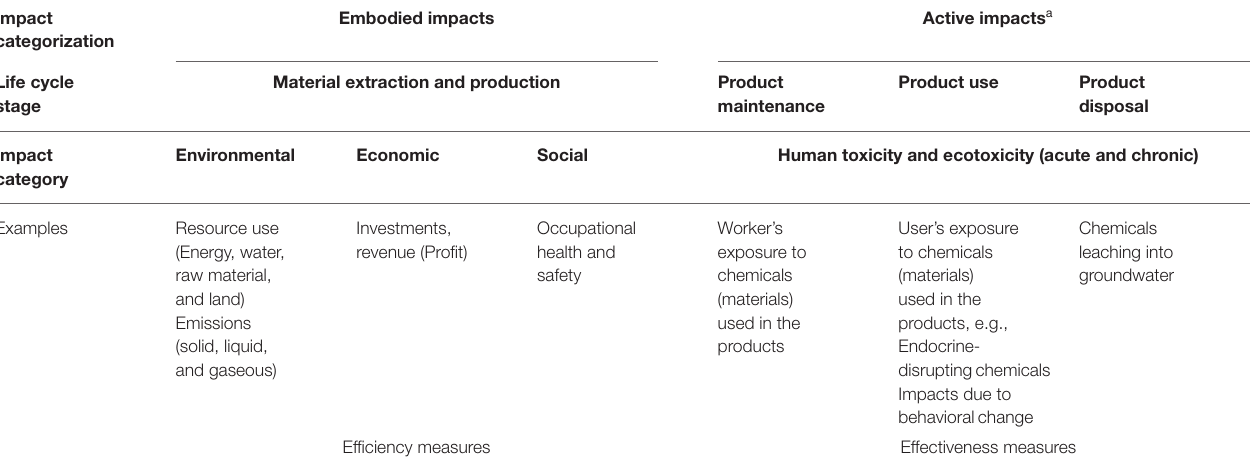
TABLE 1 | Classification of product life cycle impacts, abridged from Kumar and Mani